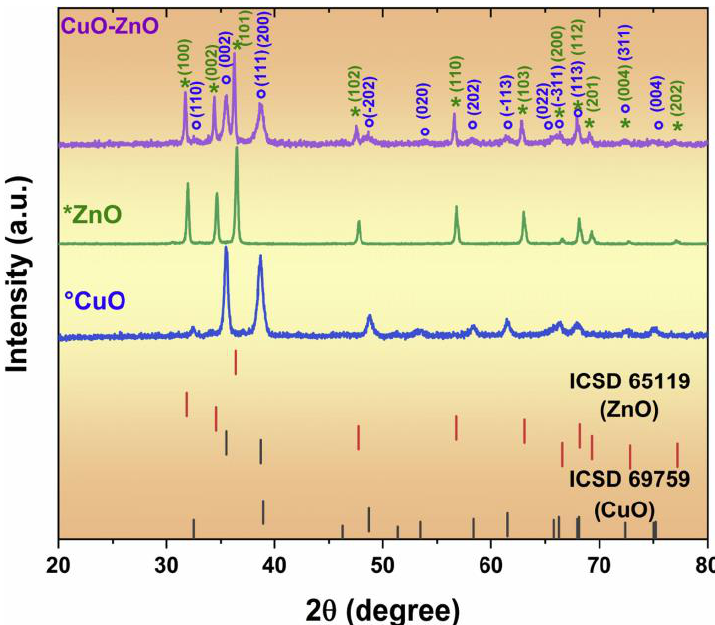
Figure 6. X-ray diffraction (XRD) pattern of samples from CuO, ZnO and CuO/ZnO heterostructure synthesized by microwave-assisted hydrothermal method [125].